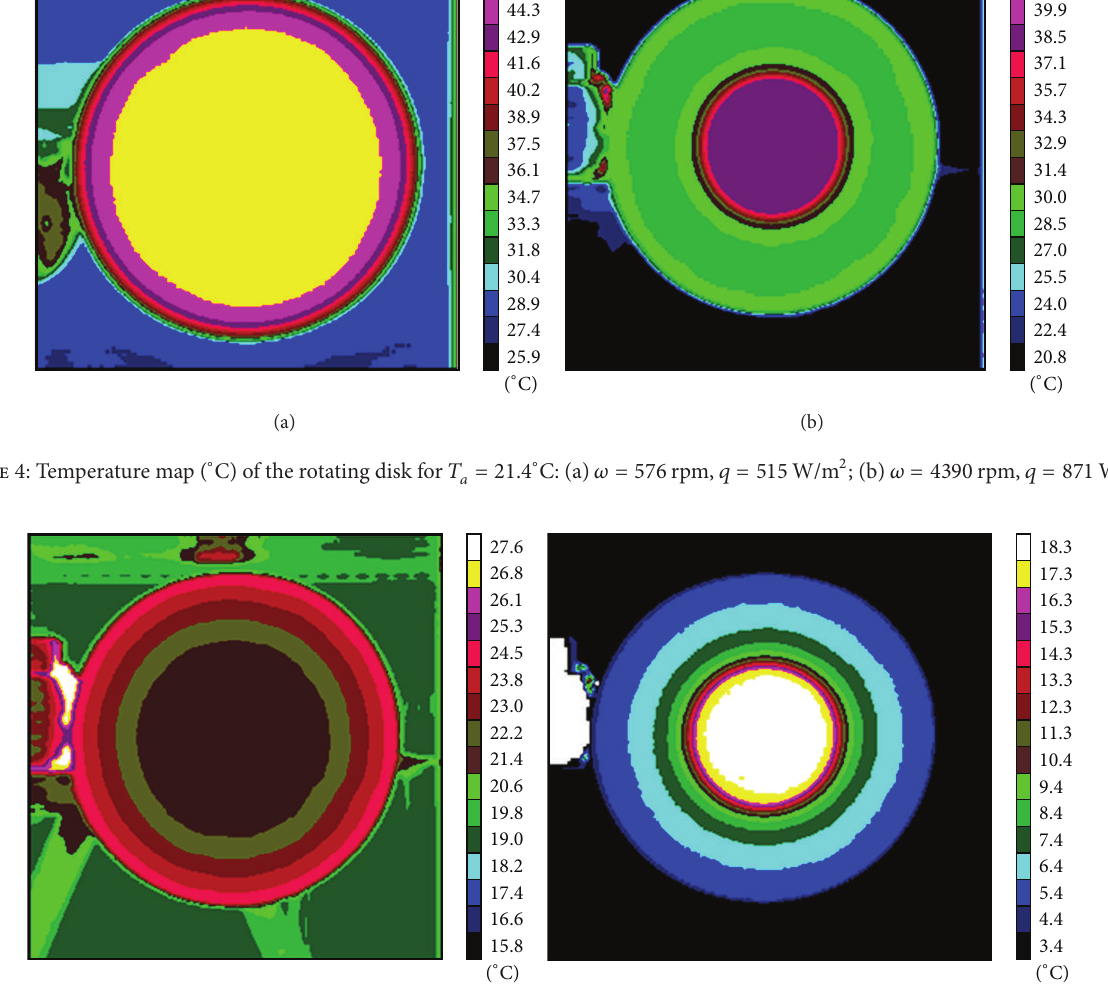
( ∘ C), 𝑞 = 0 W / m 2 ; (b) temperature difference 𝑇 𝑤 − 𝑇 aw